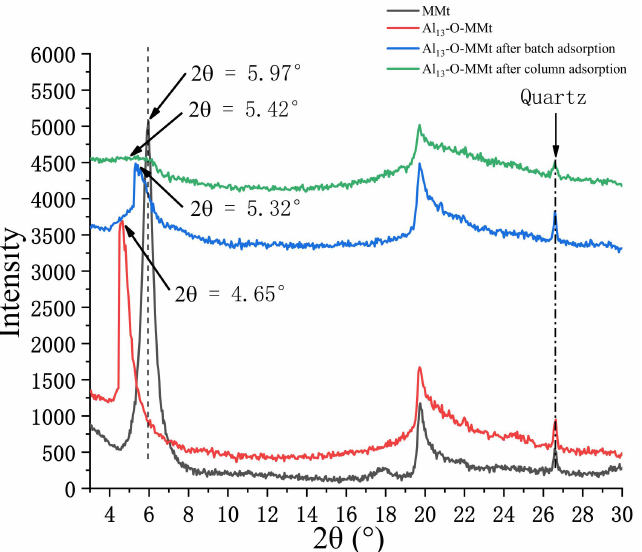
Figure 7. XRD pattern for comparison of MMt, Al 13 -O-MMt, and Al 13 -O-MMt after batch and column adsorption. 26.58 ◦ 2 θ is the quartz diffraction used as the internal standard for spacing